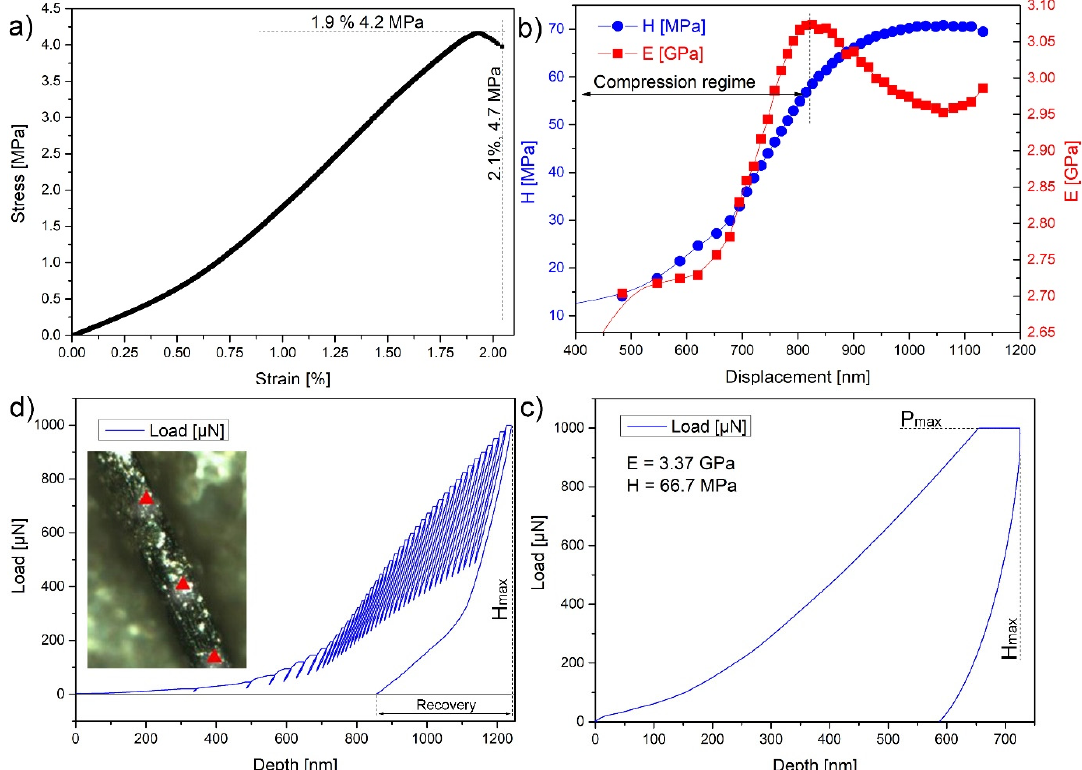
Figure 4. ( a ) Tensile stress–strain curve of typical partially reduced graphene oxide (prGO) fiber; ( b ) mechanical values extracted from partial load / unload test; ( c ) load vs. displacement plot of a representative indent showing maximum load (P Max ) and maximum displacement (H Max ); the compressive regime is marked in dashed lines; ( d ) elastic recovery of the fibers after maximum deformation (inset shows the representative indentation places).